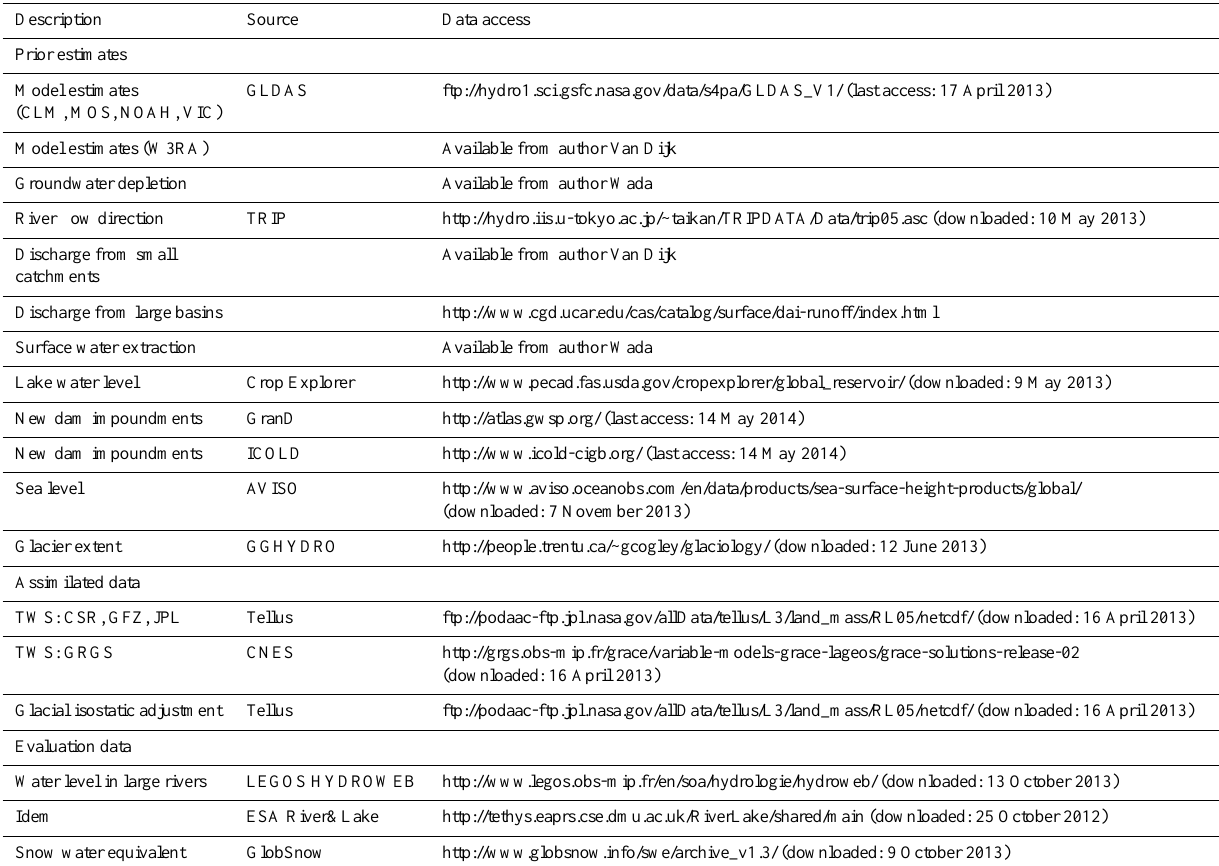
Table 1. Description and sources of data used in this analysis. Acronyms are explained in the